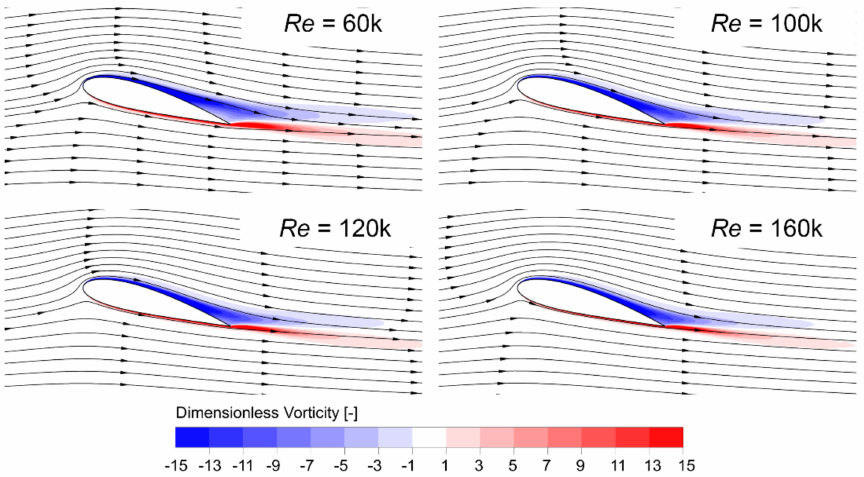
Figure 12. Vorticity contours and velocity streamlines around the blade at 15 ◦ incidence for di ff erent